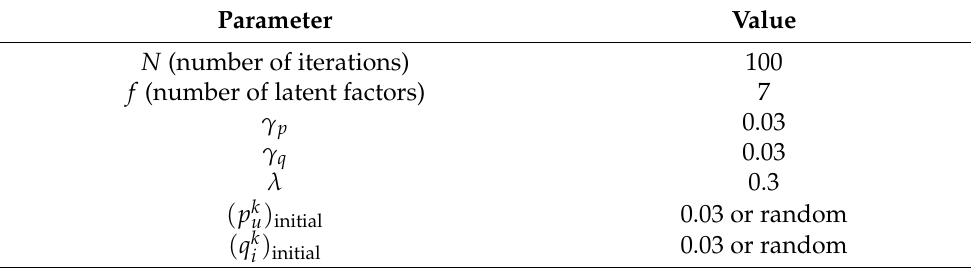
Table 1. The parameter values used in our baseline gradient descent